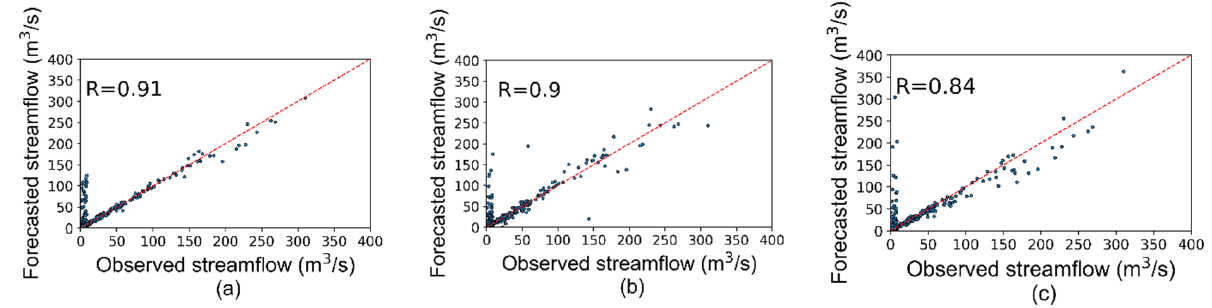
Figure 10. The scatter plots show the correlation between the observed and 1-day-ahead forecasted